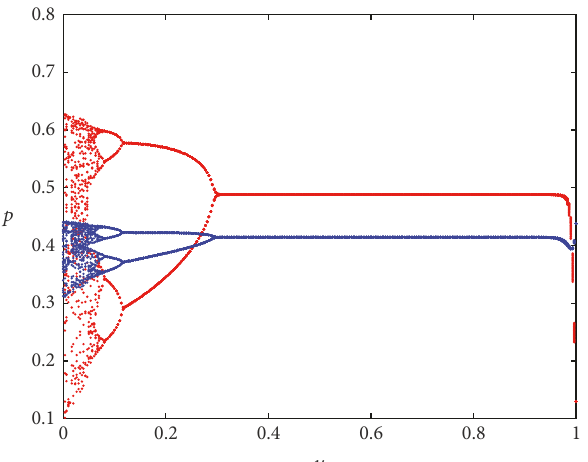
Figure 14: Bifurcation diagram of 𝑝 when 𝑢 varies from 0 to